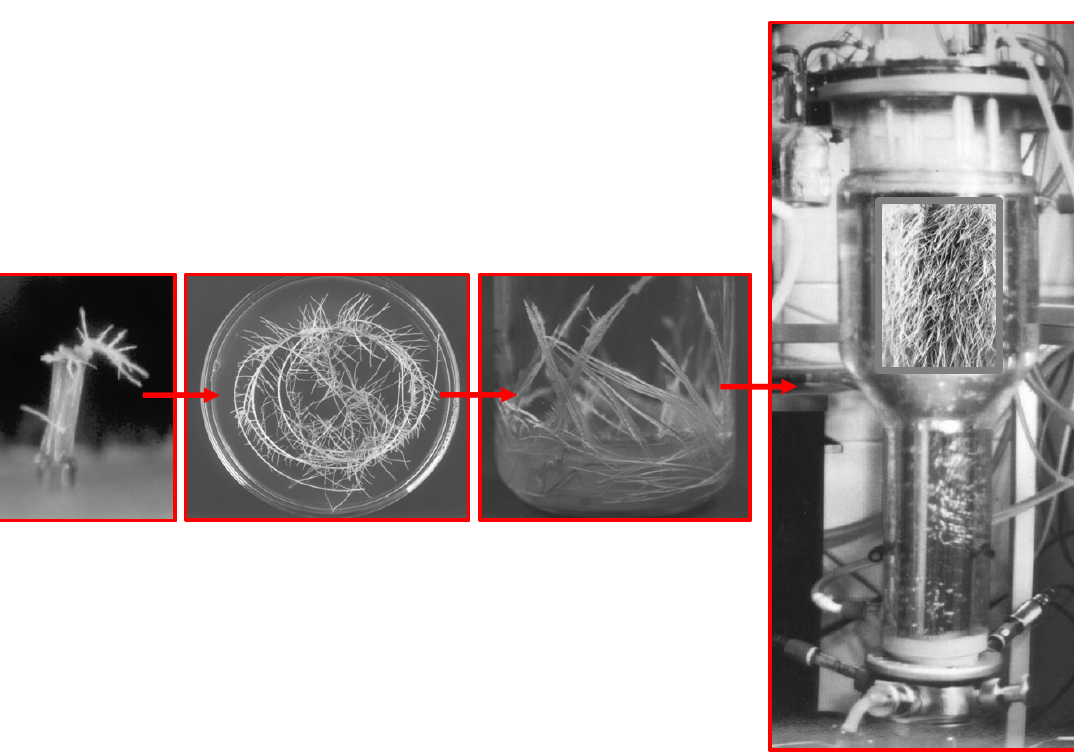
Figure 4 . The main steps for the establishment and culture of hairy roots from Datura metel